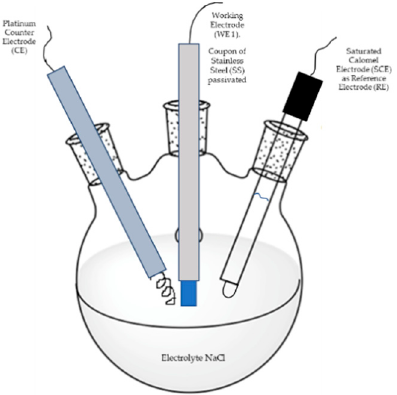
Figure 2. Conventional three-electrode cell configuration used in the potentiodynamic polarization curves (PPC) tests.